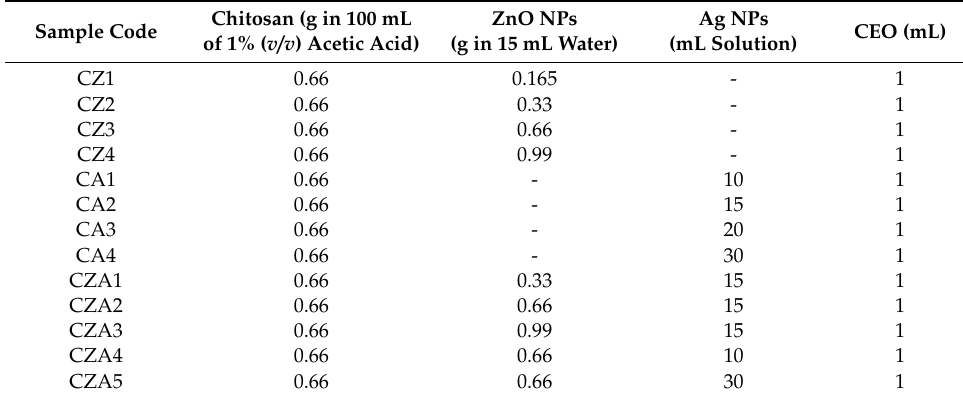
Table 1. The chitosan–nanoparticles–citronella essential oil (CEO) films composition. Sample